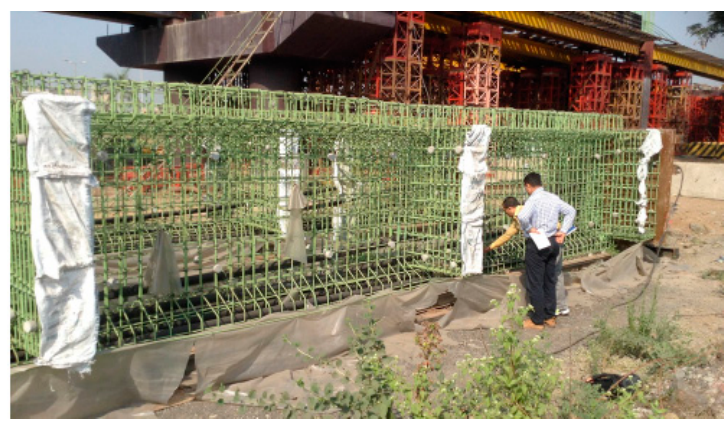
Figure 5. Sensors on reinforcement cage.